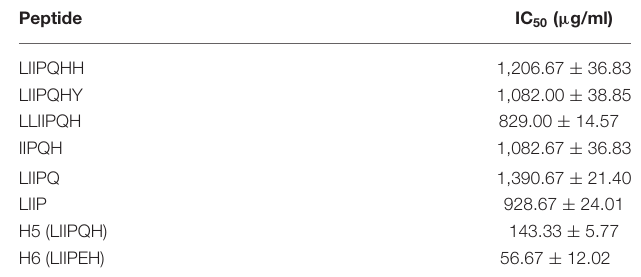
TABLE 5 | IC 50 -values of synthetic